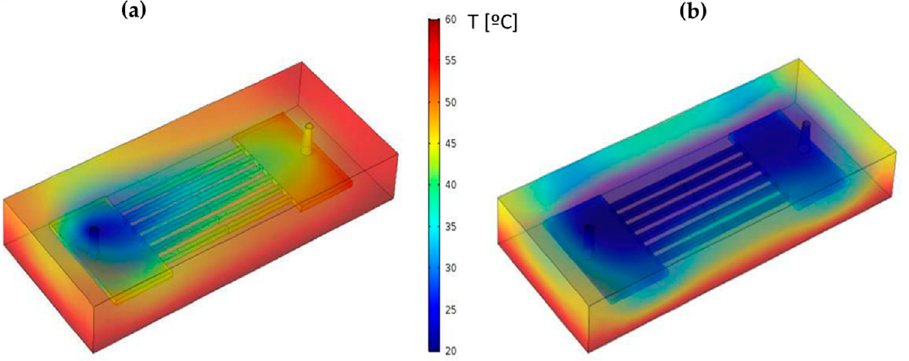
Figure 6. View of the temperature profile of a fluid flow at different flow rates:( a ) 1 mL/min; ( b ) 30 mL/min.